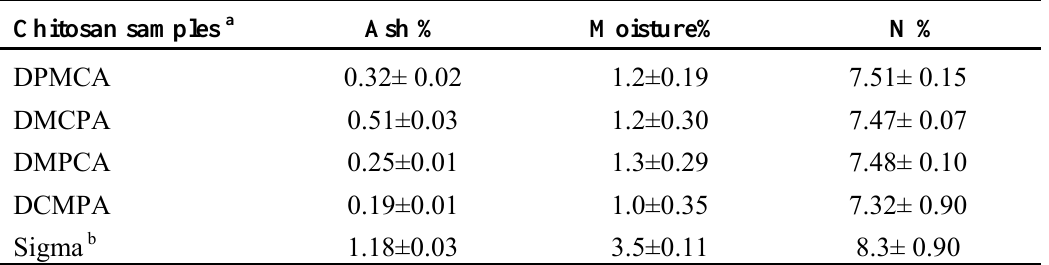
Table 1. % Ash, moisture and nitrogen of A. urmiana and commercial chitosan samples.